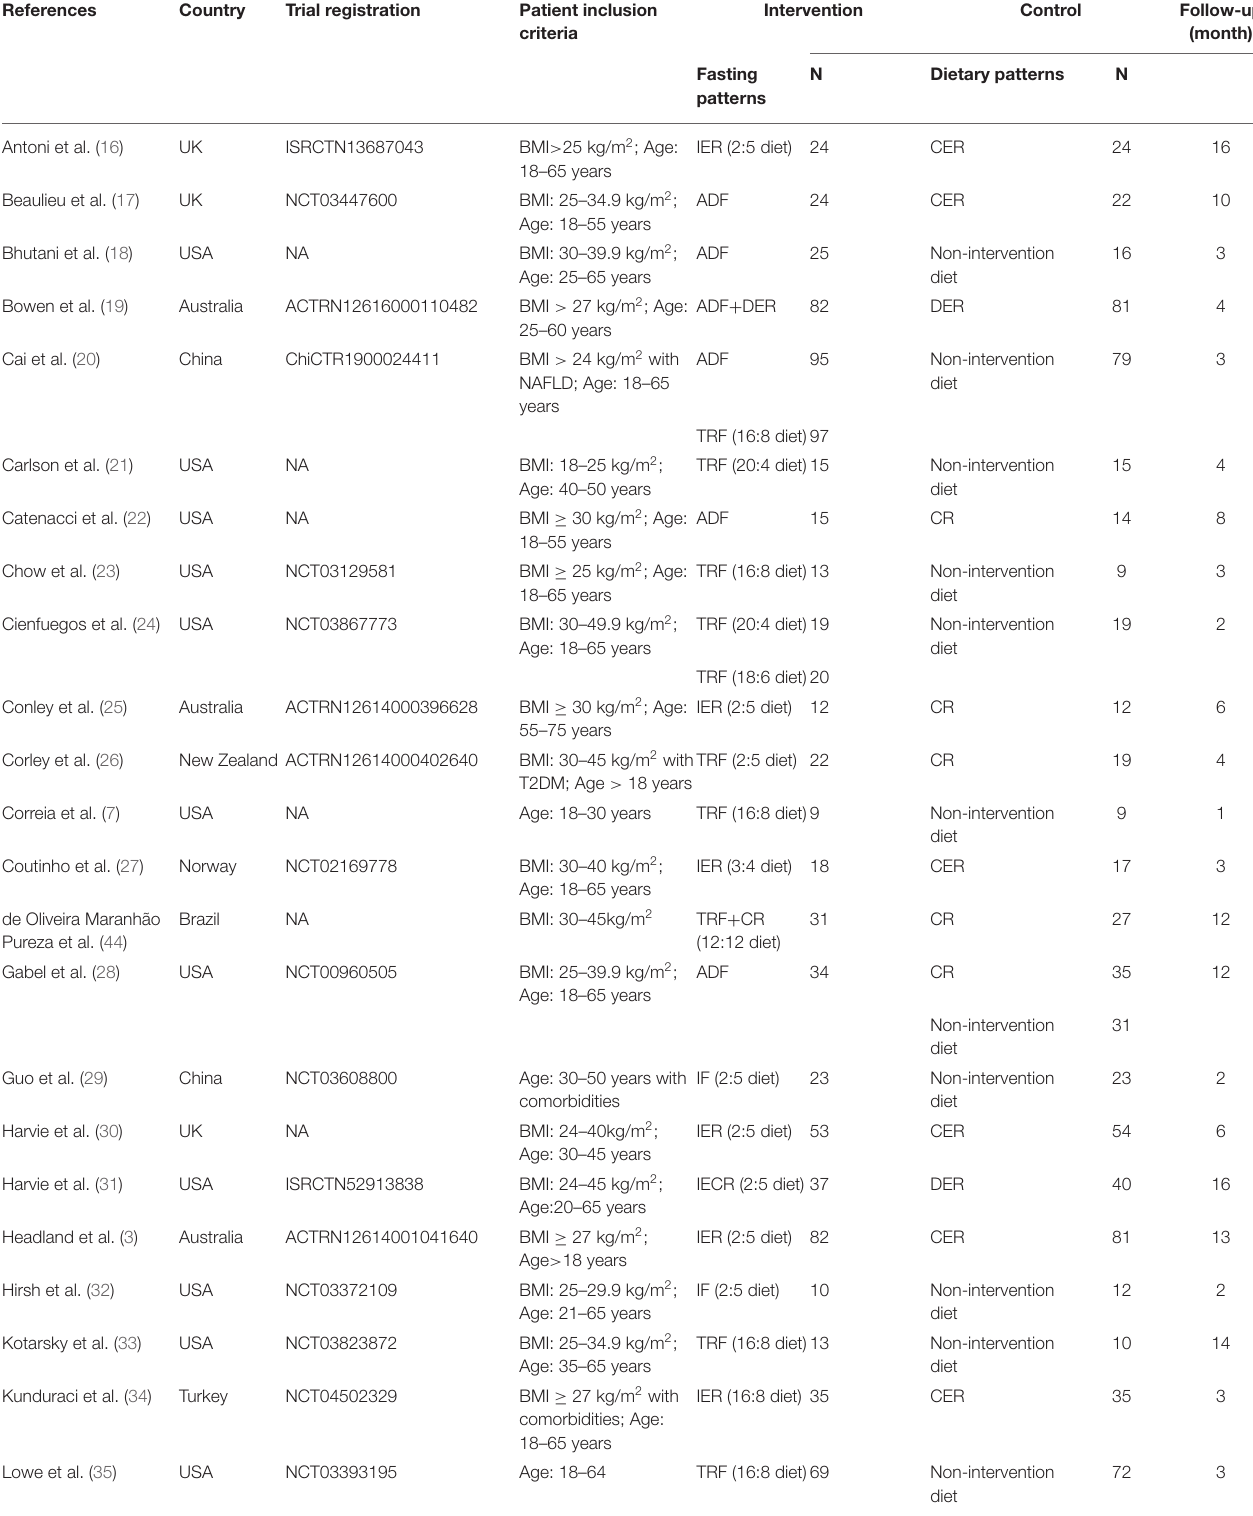
TABLE 1 | Characteristics of included RCTs in the